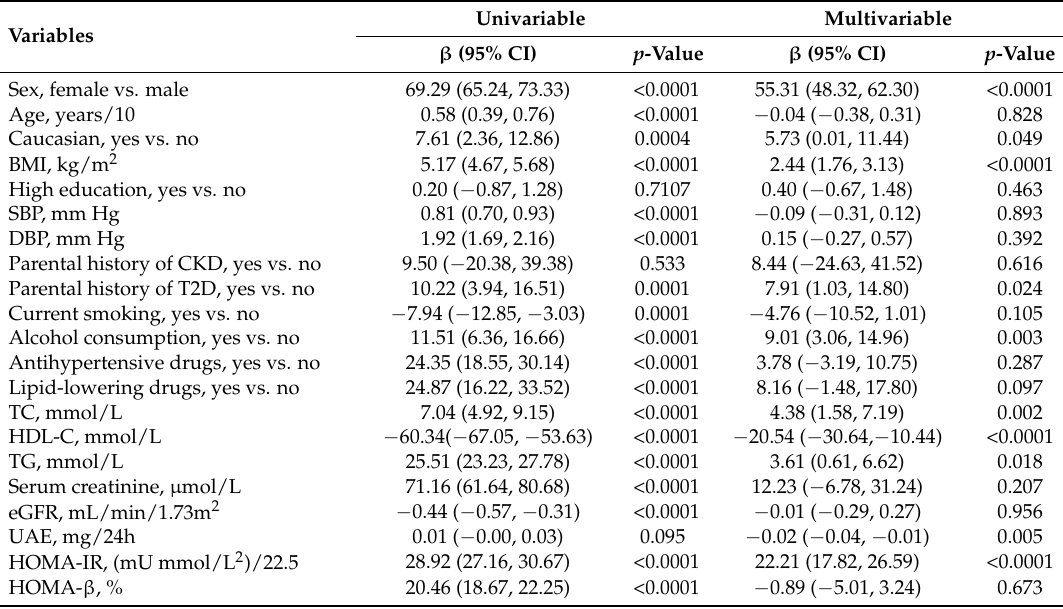
HOMA-IR, (mU mmol/L 2